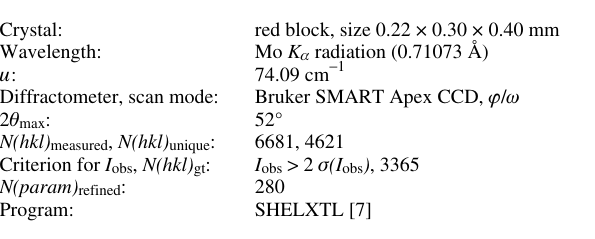
Table 1. Data collection and handling.